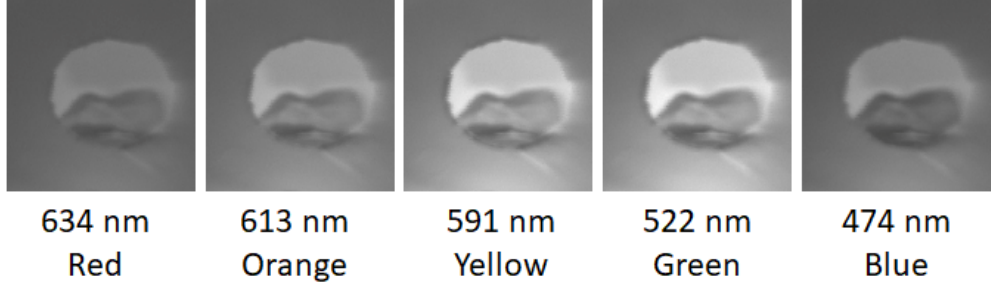
Figure 9. Variations in reflectance across the hyperspectral data for the sulphur target. Images taken from a 128 × 128 pixel scan.